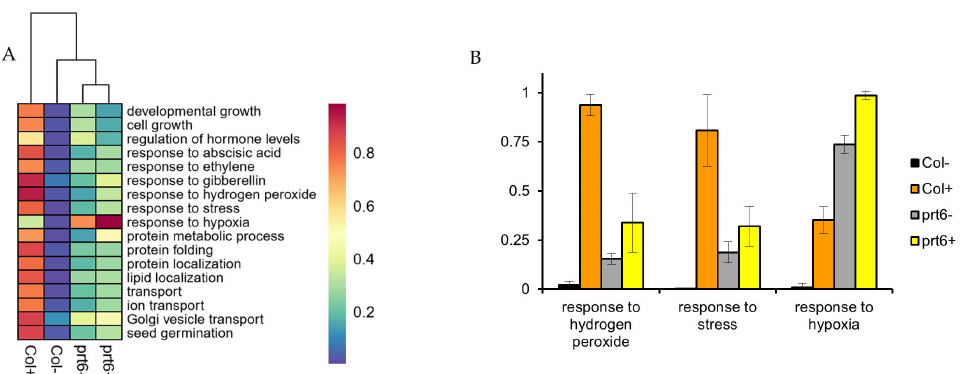
Figure 7. Individual pathway deregulation scores (PDS) of the selected biological process in 4 samples showing by heatmap clustering ( A ) and bar plot ( B ). In the heatmap, blue to red represents the PDS score from low to high.